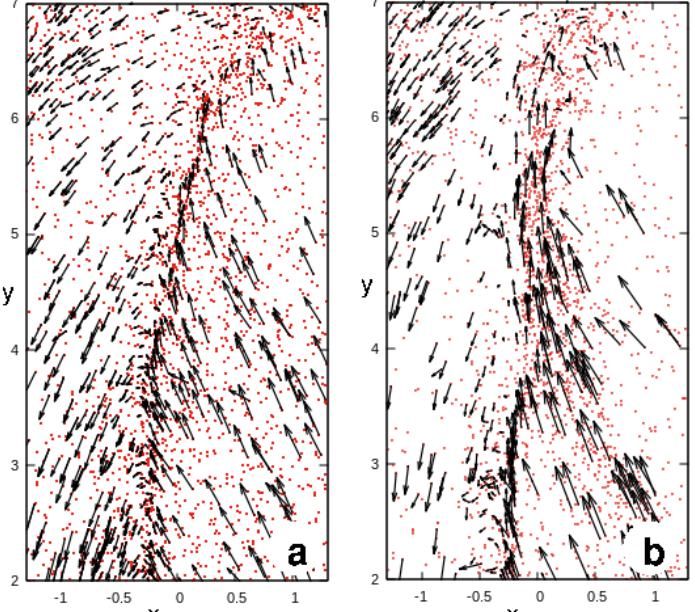
Figure 10. The flow in the straight-line shocks region in two typical cases. ( a ) During the growing bar phase. ( b ) During the time the bar has a constant amplitude ( t > 3 T ) . We can observe in ( b ) how the particles of the bifurcating tail help the shock extend to larger distances from the center, as they flow upwards in the direction opposite to the rotation of the